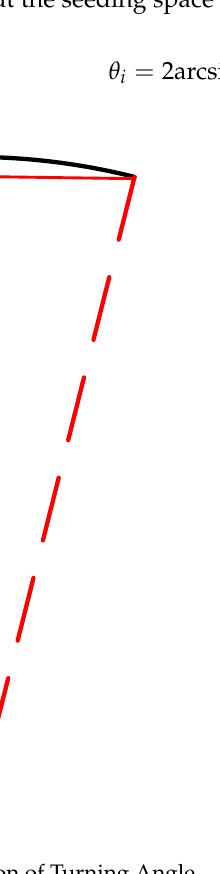
Figure 5. Calculation of Turning Angle.